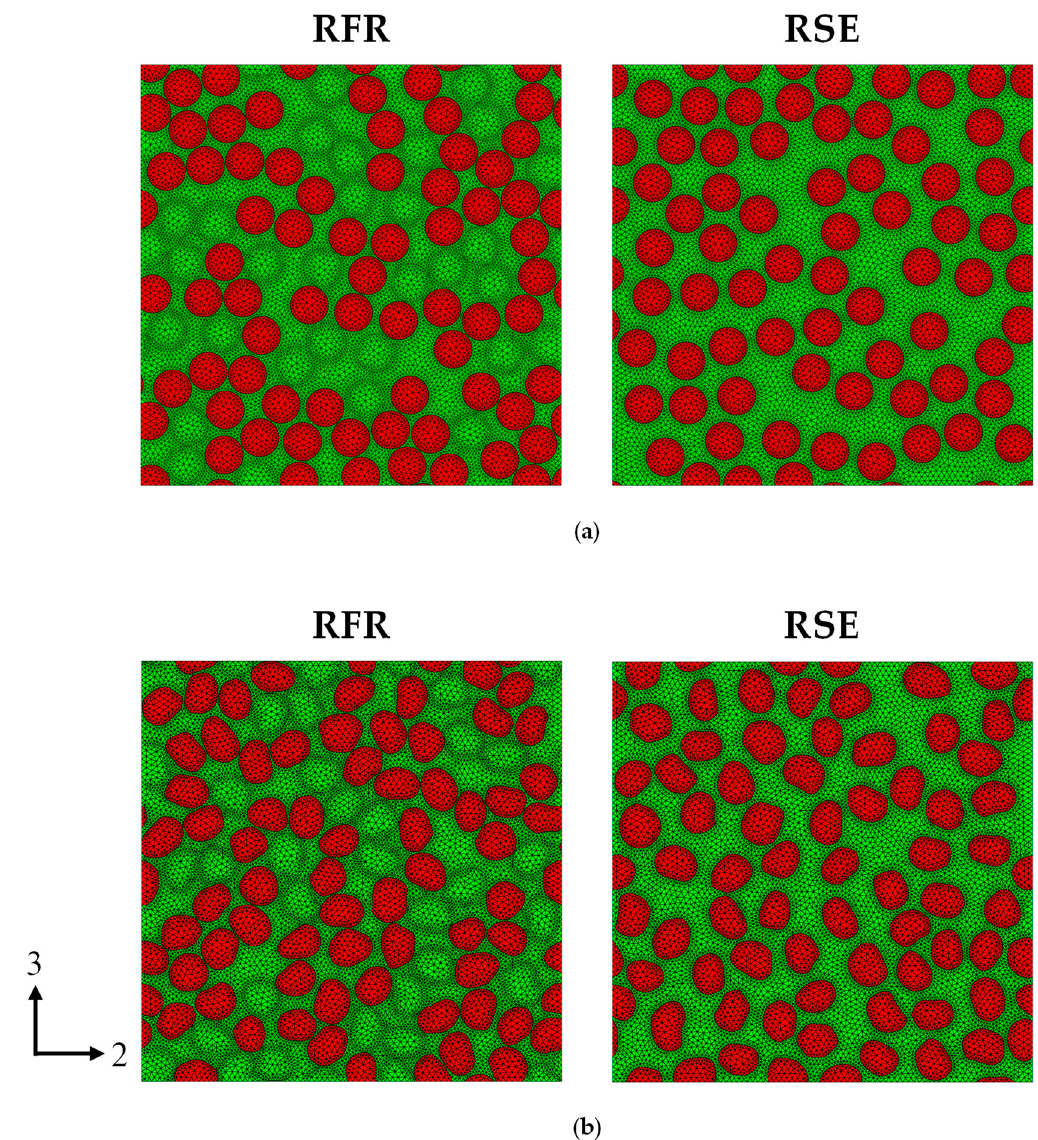
Figure 6. RVE samples of V f = 45%: ( a ) conventional circular approach and ( b ) shape-library approach. Table 2. Mean, SD, and RSD of V f of RVE samples corresponding to V req